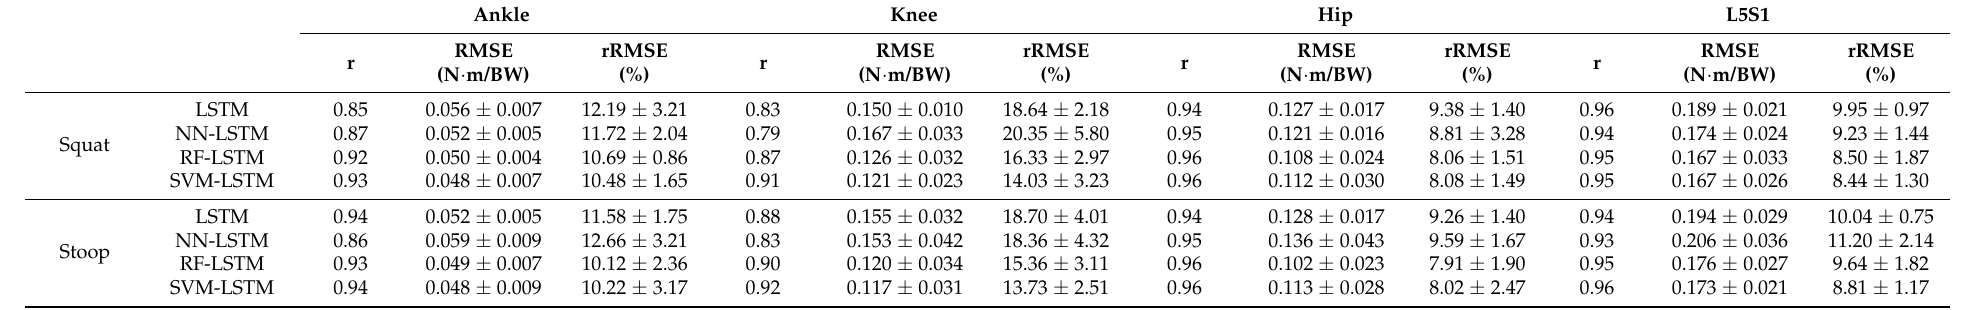
Table 5. RMSE, rRMSE and R (correlation coefficients) values between calculated joint moment from optical tracking system and predicted joint moment with a hierarchical deep learning model.